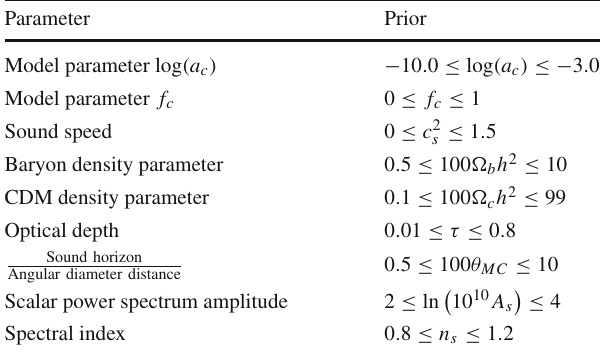
Table 2 Priors for cosmological parameters in the exponential acoustic dark energy model Parameter Prior Model parameter log ( a c